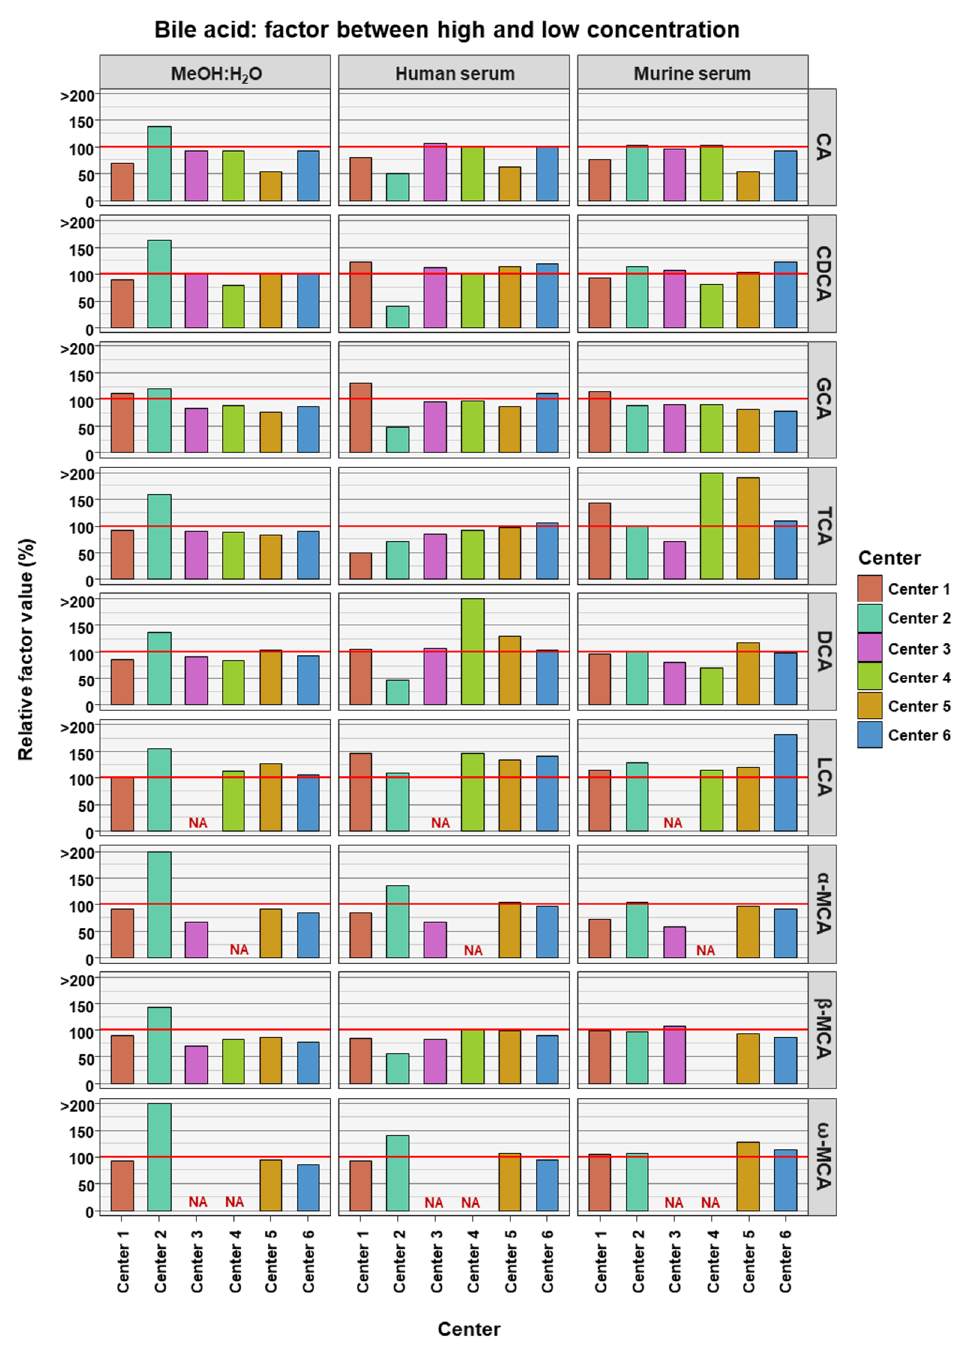
Figure 3. Relative factor values derived from the experimental factors, calculated from the mean bile acid concentrations measured in samples between the high and the low concentrations, and theoretical factors, calculated from the known spike-in concentrations. NA = not applicable, those BAs are not covered by the specific center.